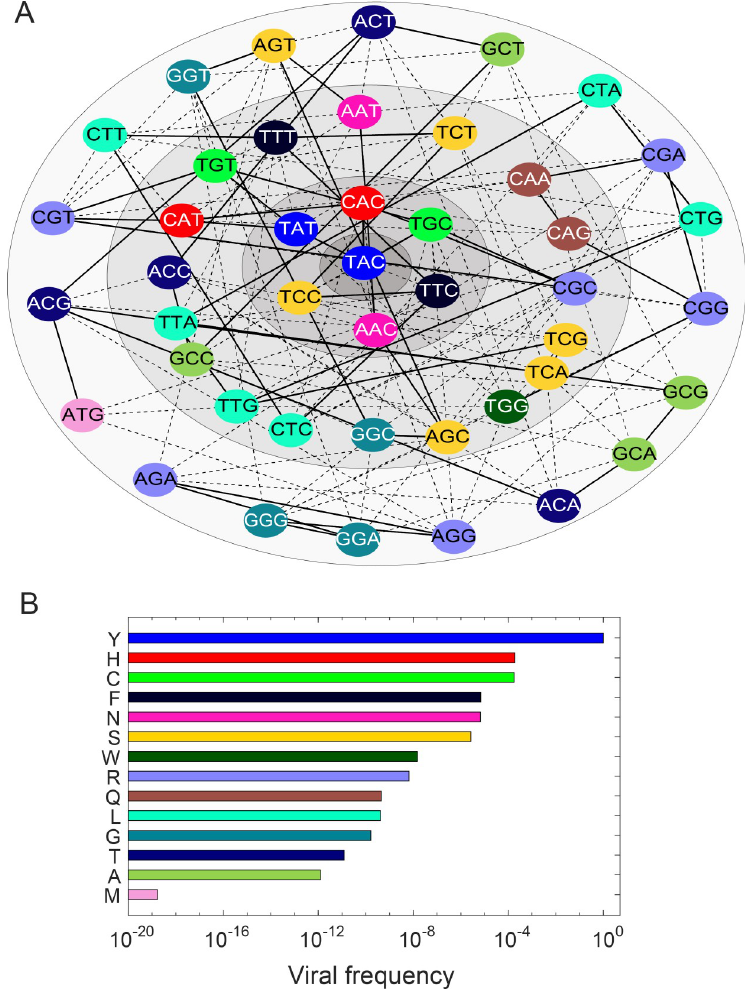
Fig 7. The mutant spectrum at position 93 of the NS5A protein. (A) The map of mutational pathways depicted circularly for compactness. Transitions are in solid lines and transversions in dashed lines. Annuli of increasingly lighter shades of grey represent increasing numbers of mutations from the founder strain, TAC, defining the amino acid Y at position 93 of the NS5A protein of HCV. (B) The frequencies of different variants at this